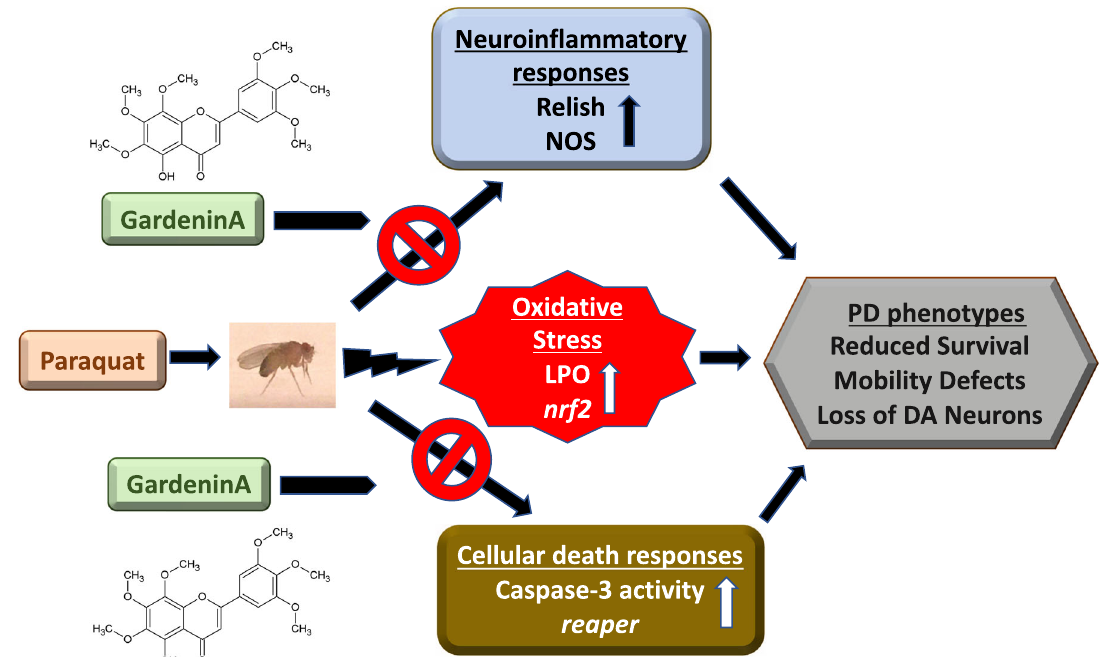
Fig. 7 Schematic representation of GardeninA-mediated neuroprotection against PQ-induced PD phenotypes in Drosophila . PQ exposure induces oxidative stress and leads to the activation of genes involved in the neuroin fl ammatory pathways, including Relish and nitric oxide in adult male fl ies. Furthermore, it activates the proapoptotic responses leading to PD symptoms involving increased mortality, mobility defects and progressive demise of dopaminergic neurons. The fl avonoid, GardeninA confers protection against PQ-induced neurotoxicity by inhibiting the neuroin fl ammatory and the cellular death response pathways, thereby providing protection against PD like symptoms. Interestingly, the antioxidant activity of GardeninA alone is not suf fi cient to provide protection against PQ-induced neurotoxicity. GardeninA acts on multiple pathways that are commonly associated with PD pathogenesis to reduce the neurotoxic impact of PQ in adult fl ies. Therefore, Gardenin A can be a potential multifactorial therapeutic for the prevention of PD caused by environmental